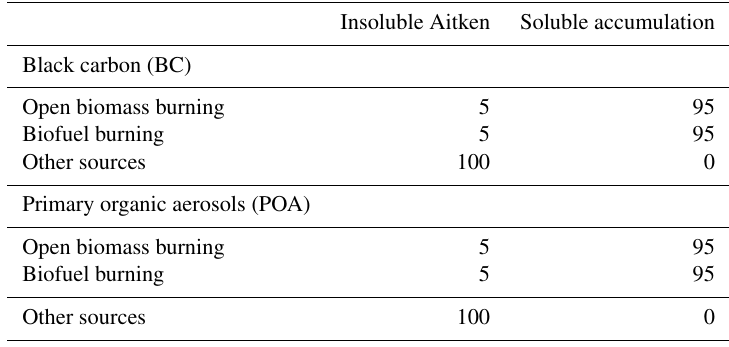
Table 4. Distribution of the carbonaceous aerosol emissions from open biomass burning, biofuel burning, and other sources over the insoluble Aitken and soluble accumulation modes, as mass percentages.